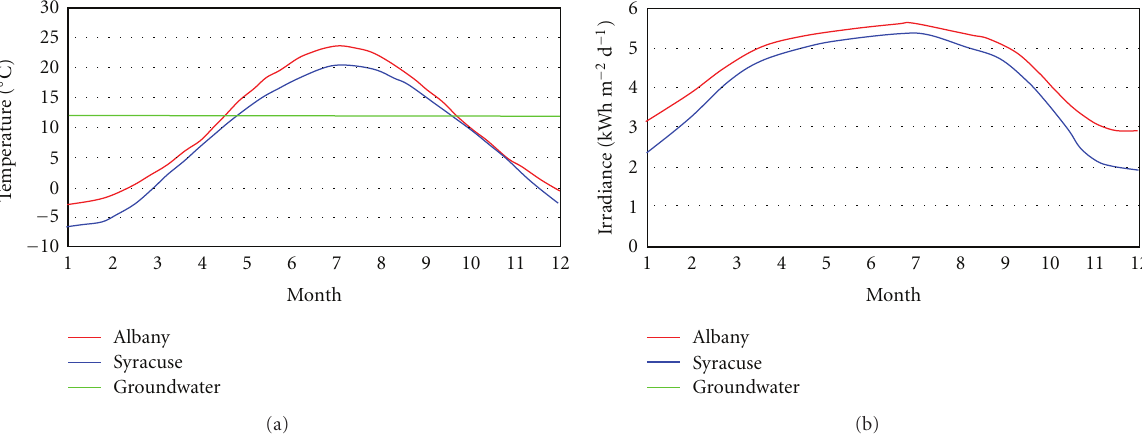
Figure 2: Monthly average temperature (a) and total monthly solar irradiance (b) for Syracuse, NY, and Albany,